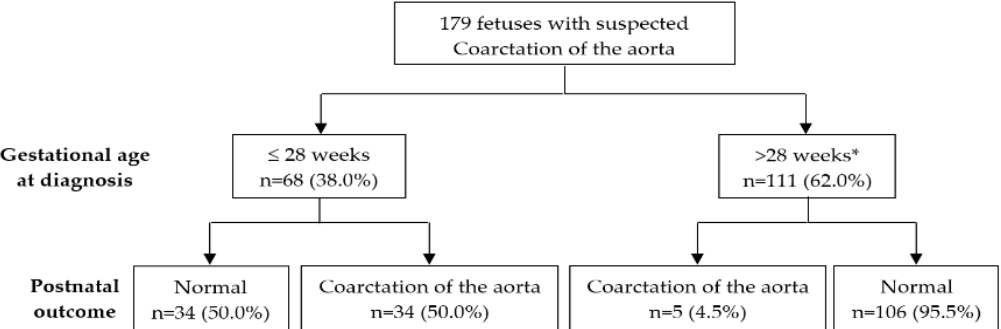
Figure 2. Postnatal outcome based on the gestational age at diagnosis. * All fetuses underwent ultrasound scan at mid- second trimester (19–22 weeks) which was informed as normal, except for three cases in which this scan was not performed, and in all 3 of these cases, CoAo was not postnatally confirmed.